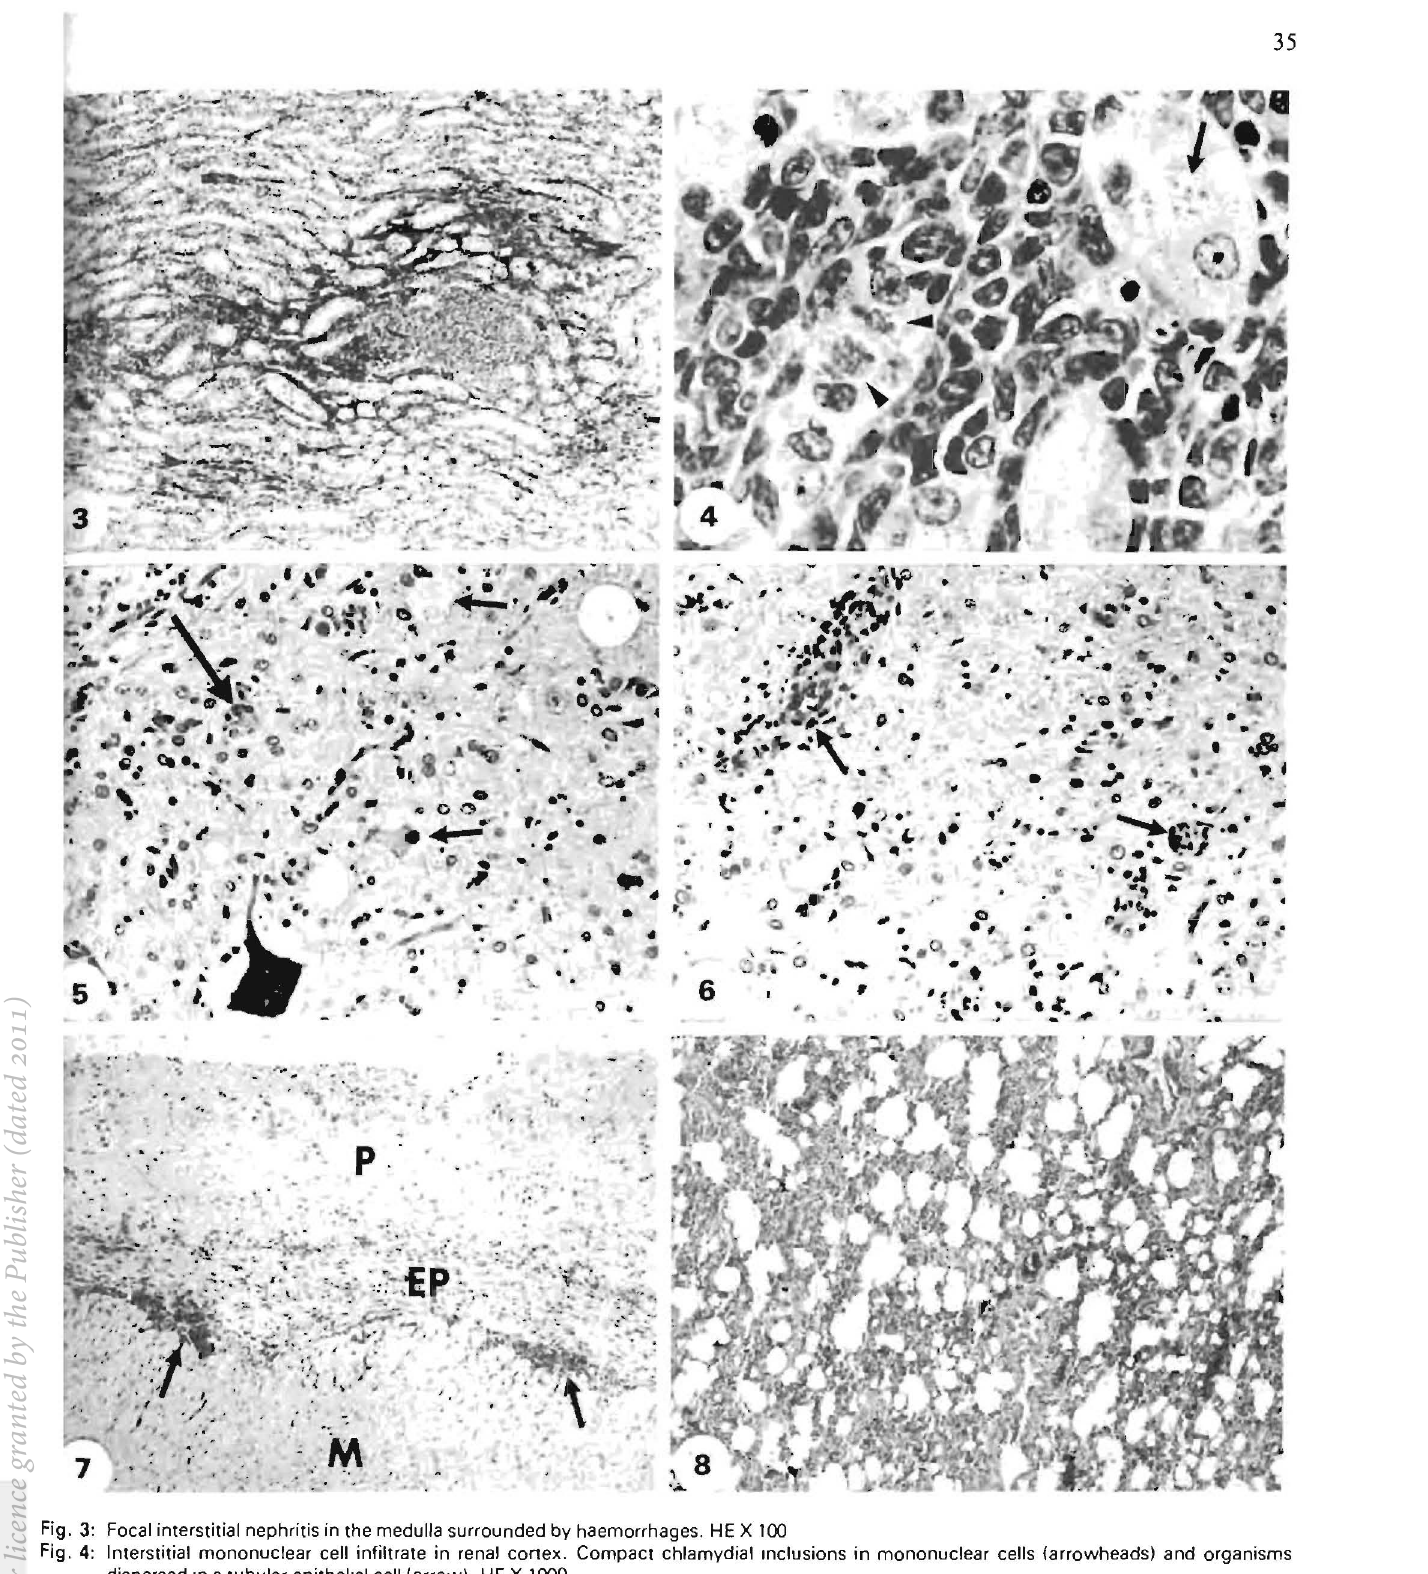
Fig. 3: Focal interstitial nephritis in the medulla surrounded by haemorrhages. HE X 100 Fig. 4: Interstitial mononuclear cell infiltrate in renal conex. Compact chlamydia I Inclusions in mononuclear cells (arrowheads) and organisms dispersed In a tubular epithelial ceillarrow). HE X 1000 Fig. 5: Vacuolation of neuropil, gliosis, foci of mononuclear cells (large arrow) and necrosis of neurons (small arrows) in the grey matter of the midbrain. HE X 400 Fig. 6: Vasculitis with perivascular Infiltration constituted mostly by lymphocytes larrows) in grey matter of midbrain. HE X 500 Fig. 7: Fibrinous pericarditis (P) and thickening of epicardium IEP) by fibrosis. Mild but widespread Infiltration of Inflammatory cells in the epicar dium and adjacent myocardium 1M), forming discrete foci (arrows). HE X 200 Fig. 8: DiHuse acute interstitial pneumonia characterized by an exudation of fibrin and inflammatory cells. HE X 100 neutrophils. In certain areas the leptomeninges were oedematous and infiltrated by mononuclear